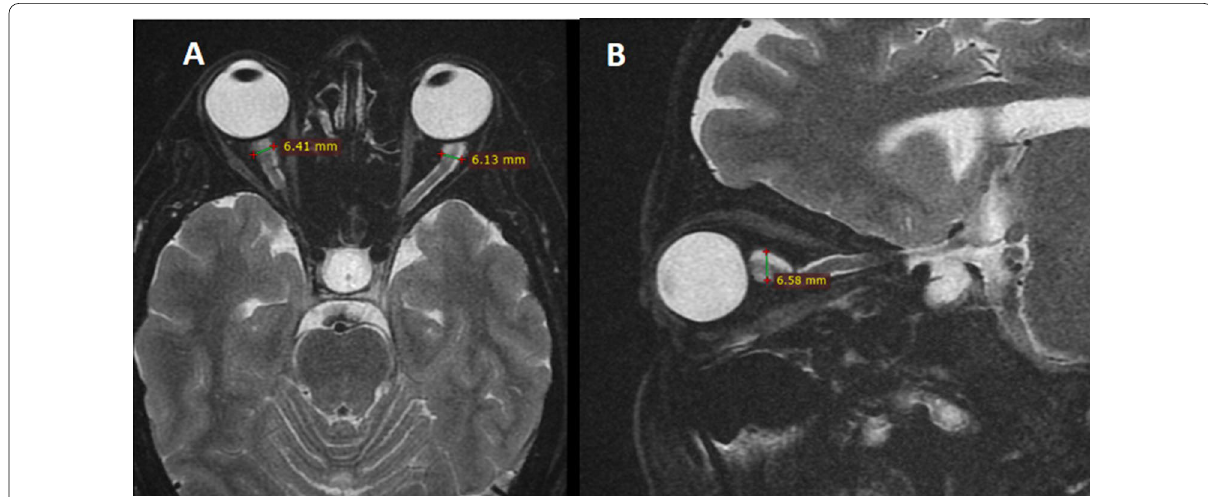
Fig. 4 A Axial T2 weighted fat saturated image of orbit demonstrates distension of perioptic sheath of bilateral optic nerve. B Sagittal T2 weighted fat saturated image of orbit demonstrates vertically tortuous of right optic nerve with distension of perioptic sheath and flattening of posterior